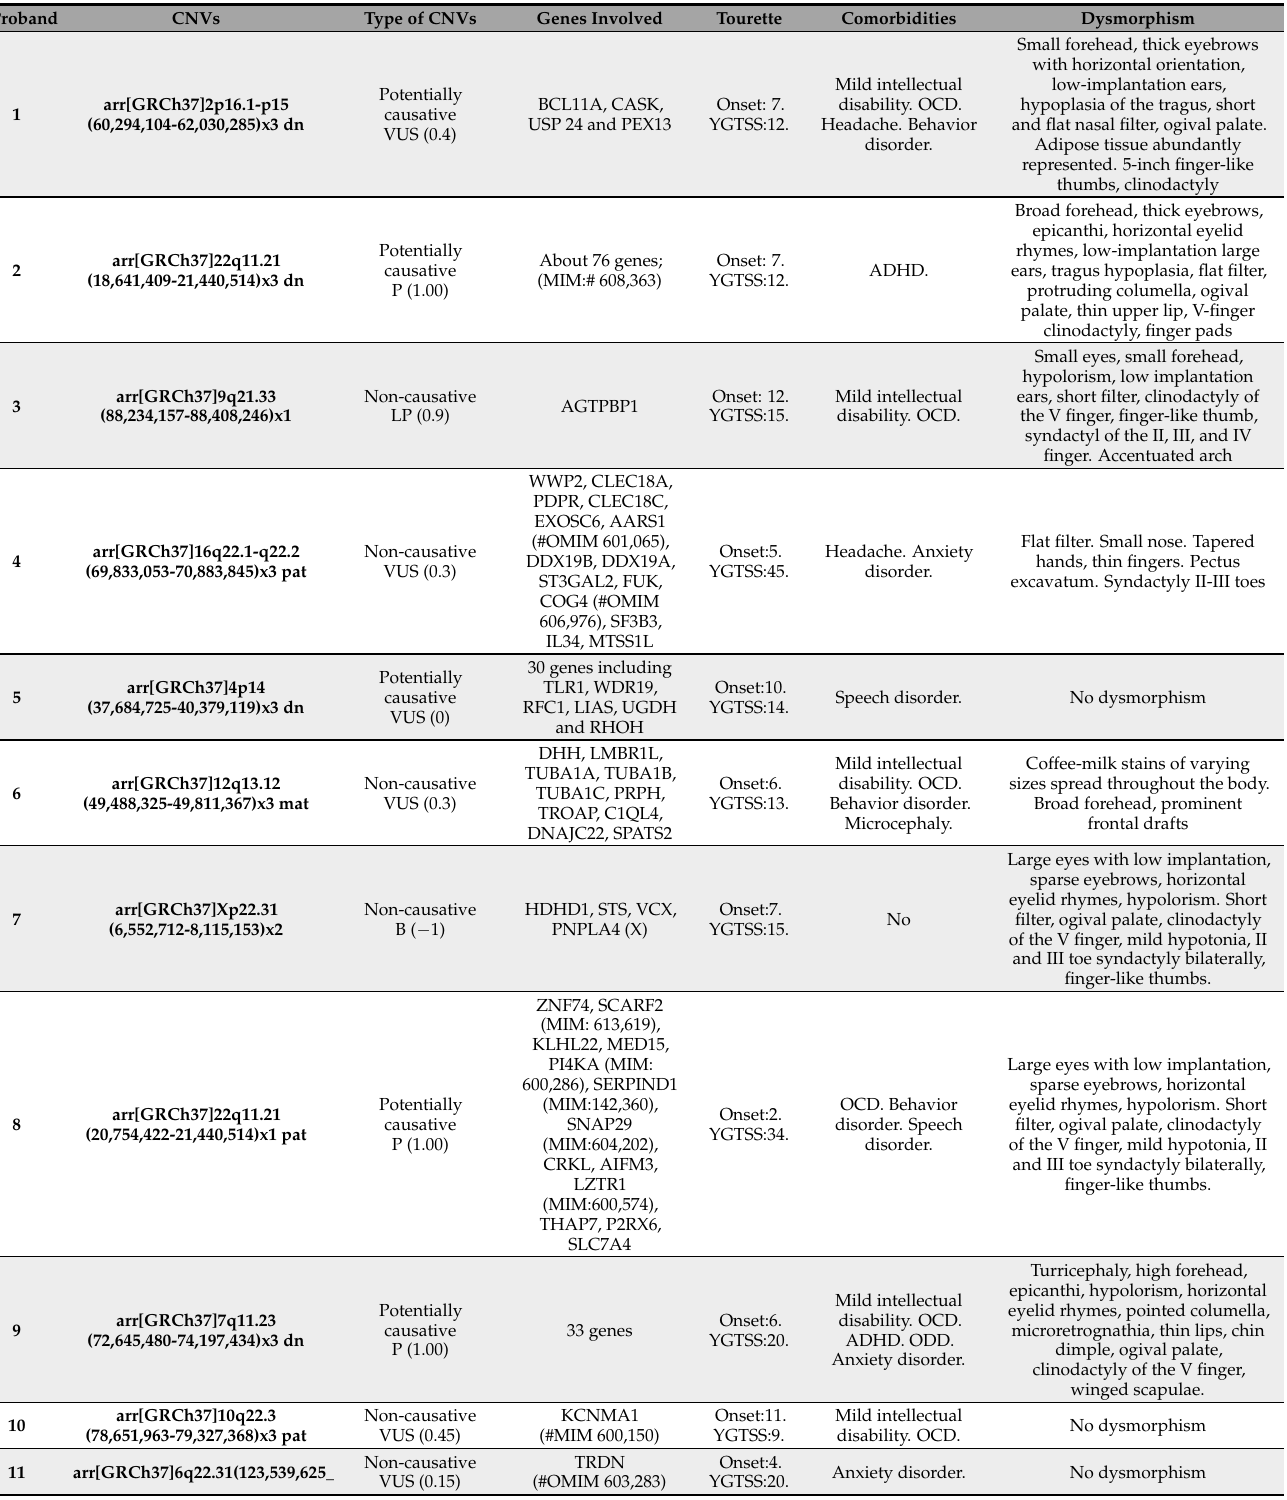
Table 3. Clinical and molecular characteristics associated with CNVs in patients with TS. https://franklin. genoox.com/clinical-db/home. ACMG: variants of uncertain significance (VUS)—score between − 0.89 and 0.89 points; likely pathogenic (LP)—score between 0.90 and 0.98 points; pathogenic (P)—score 0.99 points; likely benign (LB)—score between − 0.90 and − 0.98 points; benign (B)—score −